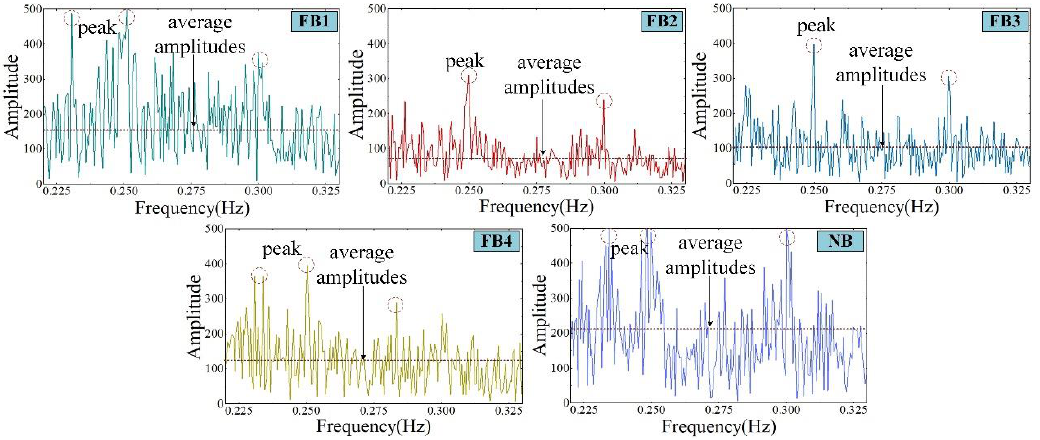
Figure 16. Broaching amplitudes of different tools at 40 mm/s.